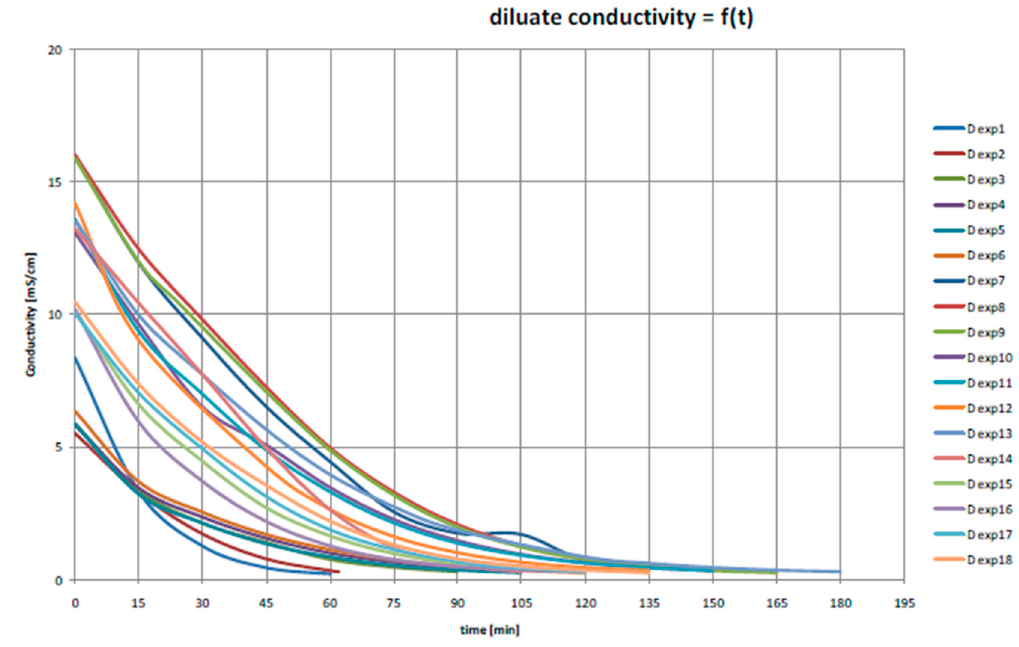
Figure 11. Time of achieving the required conductivity of diluate (0.3 mS.cm − 1 ) in 18 experiments.